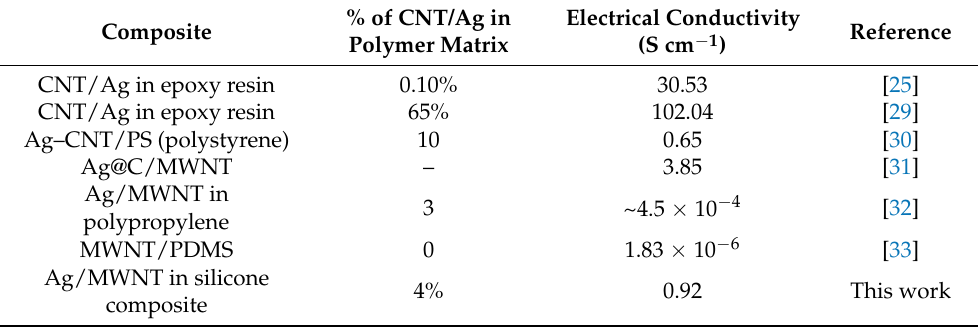
Table 1. Comparison of electrical conductivity of MWNT/Ag composite materials.